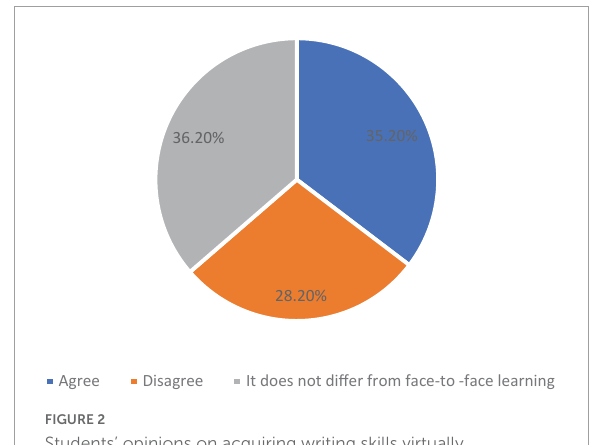
FIGURE2 Students’ opinions on acquiring writing skills